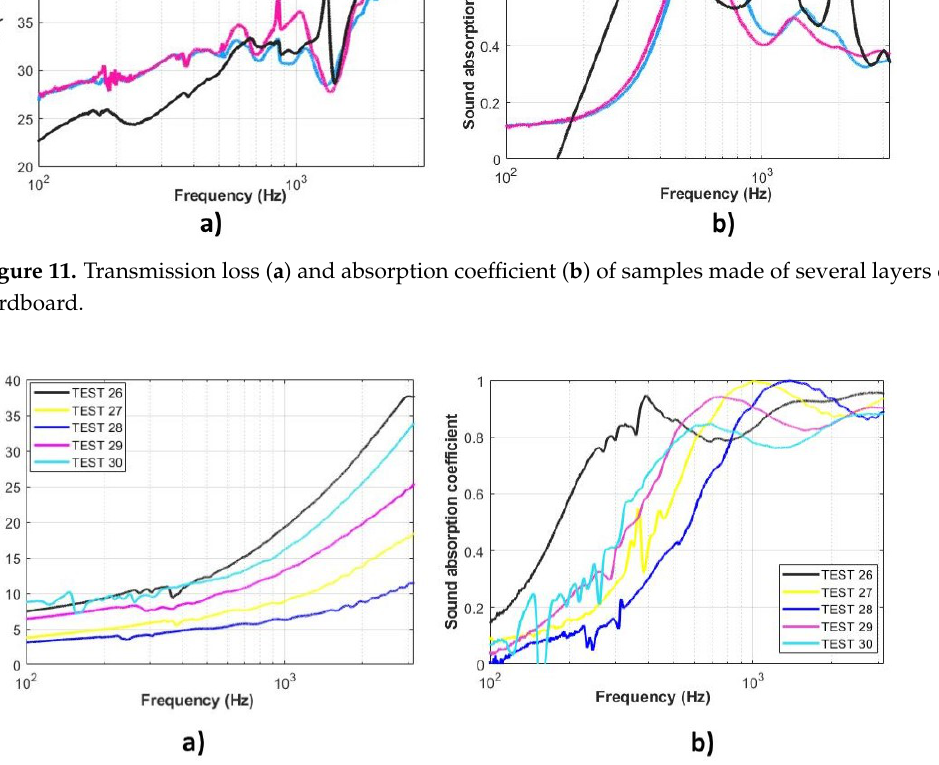
Figure 12. Transmission loss ( a ) and absorption coefficient ( b ) of samples made of clothes (one fabric at a time).